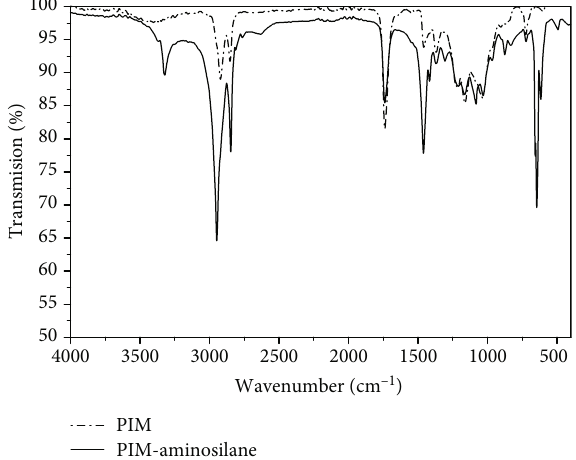
ð ω Þ and imaginary ε 1